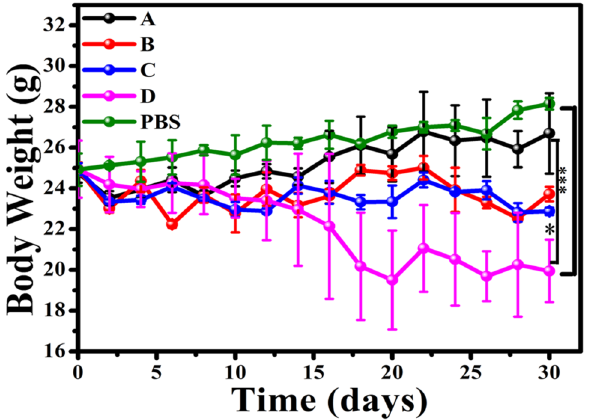
Figure 7. Body weights of mouse groups after various treatments of PhIP aerosol particles. A, B, C, D represent PhIP concentrations of 10, 20, 50, and 100 μg/mL, 10 mL. The results were given as a mean value of three independent experiments ± SD. The statistical analysis was performed by the one-way analysis of variance- ANOVA followed by Turkey’s post hoc test (* p < 0.05, ** p < 0.01, *** p < 0.001).